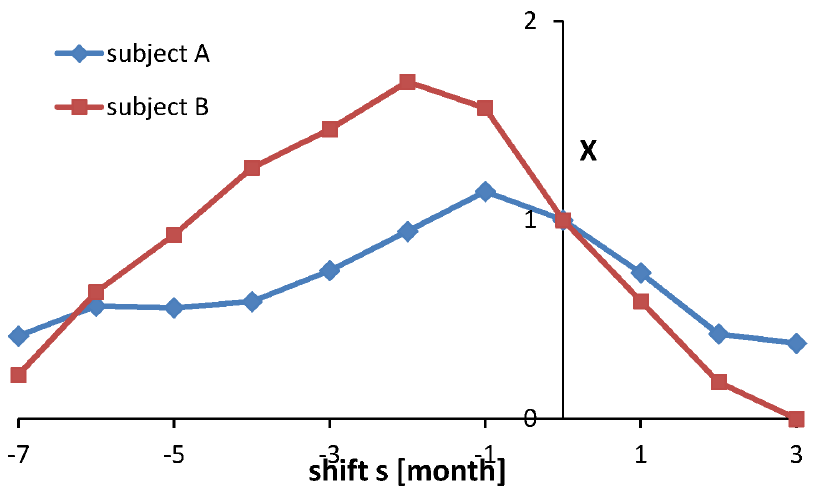
Figure 4. Cross-correlation X ( s ) of the function E ( t ) given by (10) and the block function B ( t ) which has the value 1 during dietary periods and 0 outside these